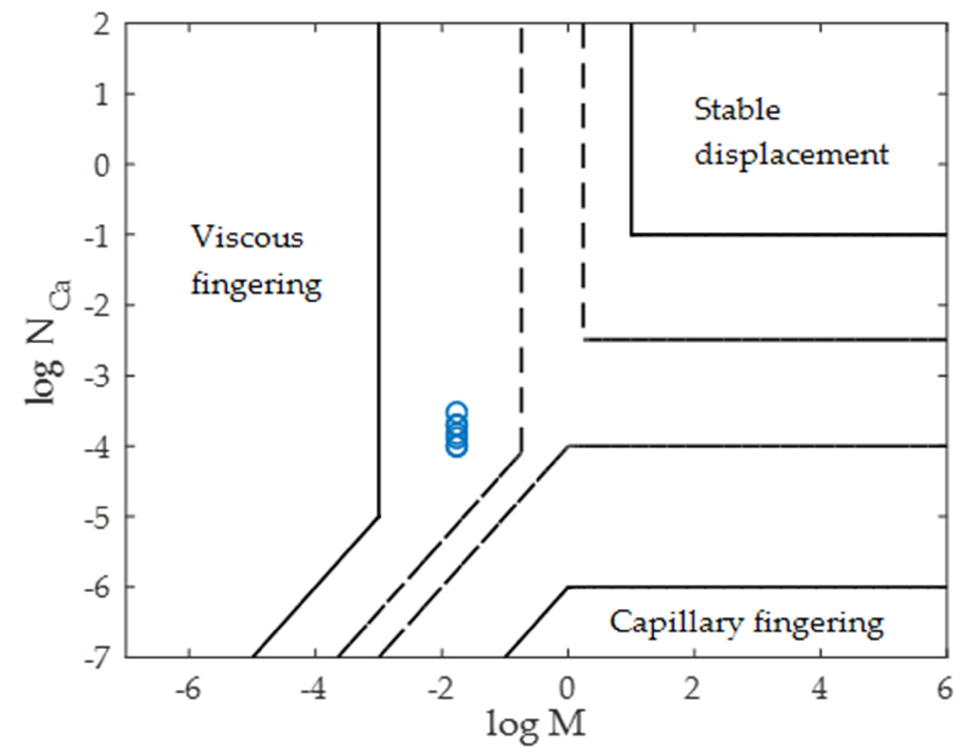
Figure 4. logN Ca vs logM phase diagram shows the three flow regimes of viscous fingering, stable displacement, and capillary fingering. The blue open circles locate experiments performed in this work. The solid black line indicates the original proposed boundaries [48], and the dashed lines represent the proposed boundaries for micromodel [49]. M is viscosity ratio of invading fluid (air) to defending fluid (liquid), it is 1.8 × 10 − 2 in this work.